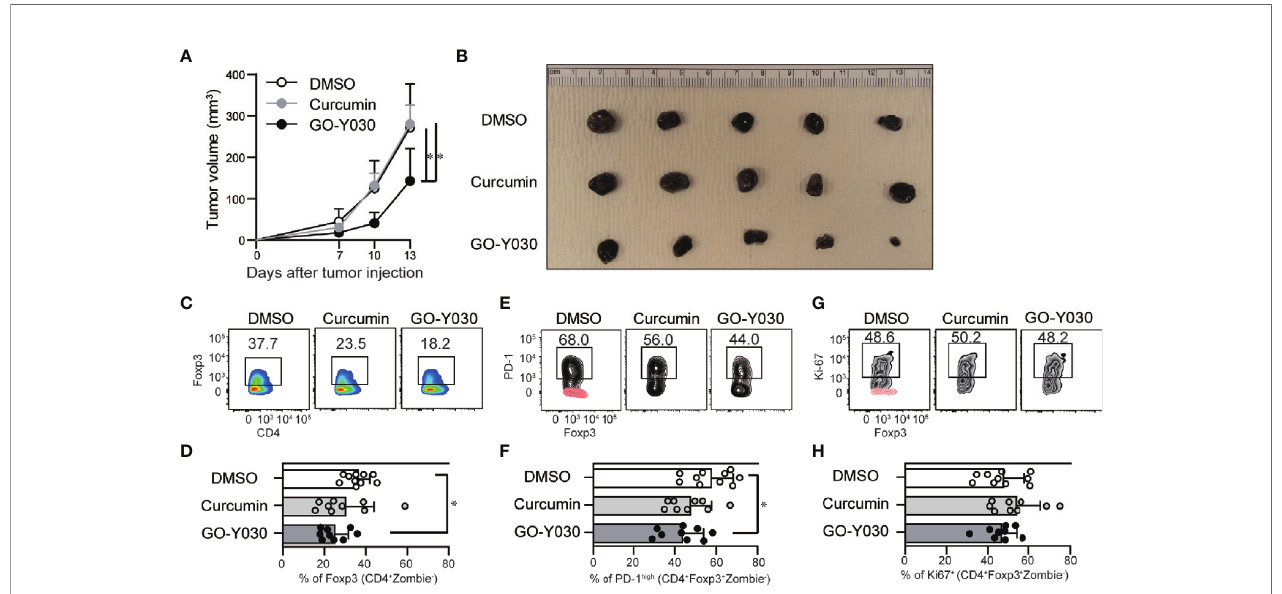
FIGURE 6 | GO-Y030 reduced Foxp3 + Tregs in tumor-in fi ltrating lymphocytes. (A) Calculation of the tumor volume (mm 3 ) for each day beginning 7 days after tumor injection (n = 9 – 10, mean + standard deviation). (B) Representative tumors in each group harvested at the end of the experiments as in (A) . (C, D) Representative intranuclear staining of Foxp3 + Tregs (CD4 + Zombie - Foxp3 + population) in tumor-in fi ltrating lymphocytes. (E, F) Representative PD-1 high population of Tregs (CD4 + Zombie - Foxp3 + population) in tumor-in fi ltrating lymphocytes. Red, isotype control; black, PD-1. (G, H) Representative Ki-67 + population in Tregs (CD4 + Zombie - Foxp3 + population) in tumor-in fi ltrating lymphocytes. Red, isotype control; black, Ki-67. Data are representative of two independent experiments (B, C, E, G) . A one-way ANOVA with post-hoc Tukey ’ s multiplecomparisonstest was used (A,D,F, H) . The graph shows the mean andstandard deviation.*P <